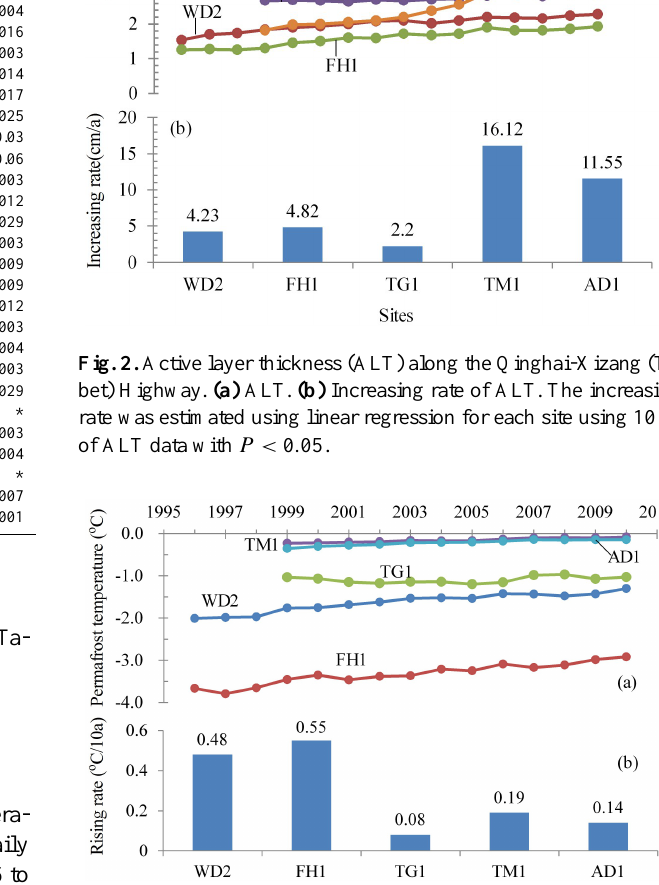
Fig. 3. Variation of permafrost temperature at 6m depth along the Qinghai-Xizang (Tibet) Highway. (a) Variation of permafrost tem- perature at 6 m depth. (b) Rate of permafrost temperature change at 6m depth. The rate of permafrost temperature change was estimated using linear regression, with P < 0 .